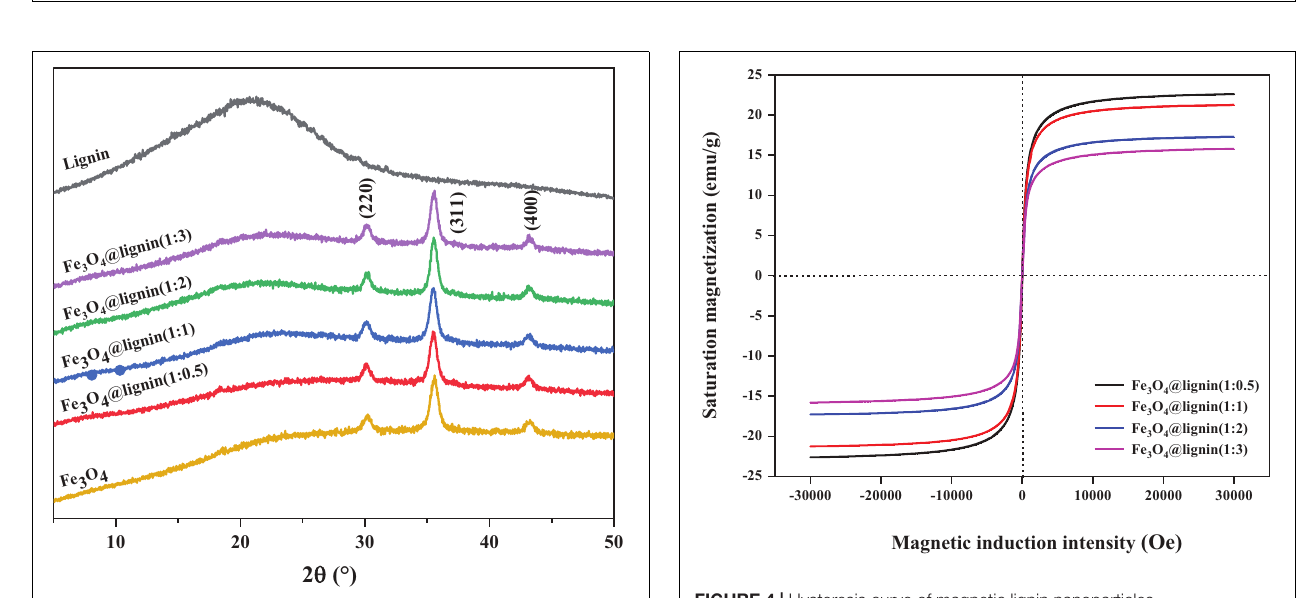
FIGURE 2 | TEM image of Fe 3 O 4 and magnetic lignin (A) Fe 3 O 4 , (B) Fe 3 O 4 @lignin (1:0.5), (C) Fe 3 O 4 @lignin (1:1), (D) Fe 3 O 4 @lignin (1:2), (E) Fe 3 O 4 @lignin (1:3).